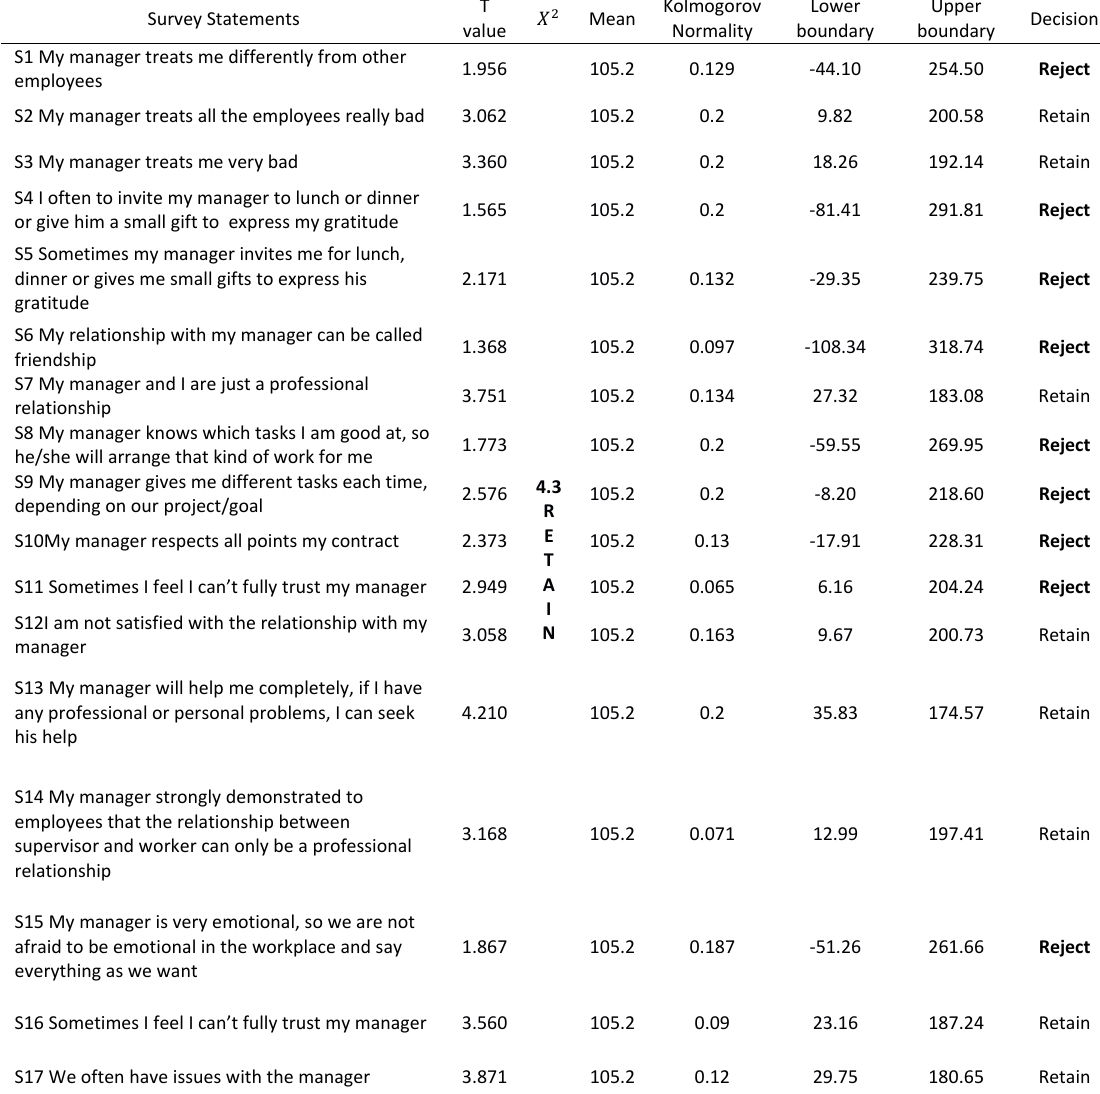
Table 5: hypothesis testing for local workers